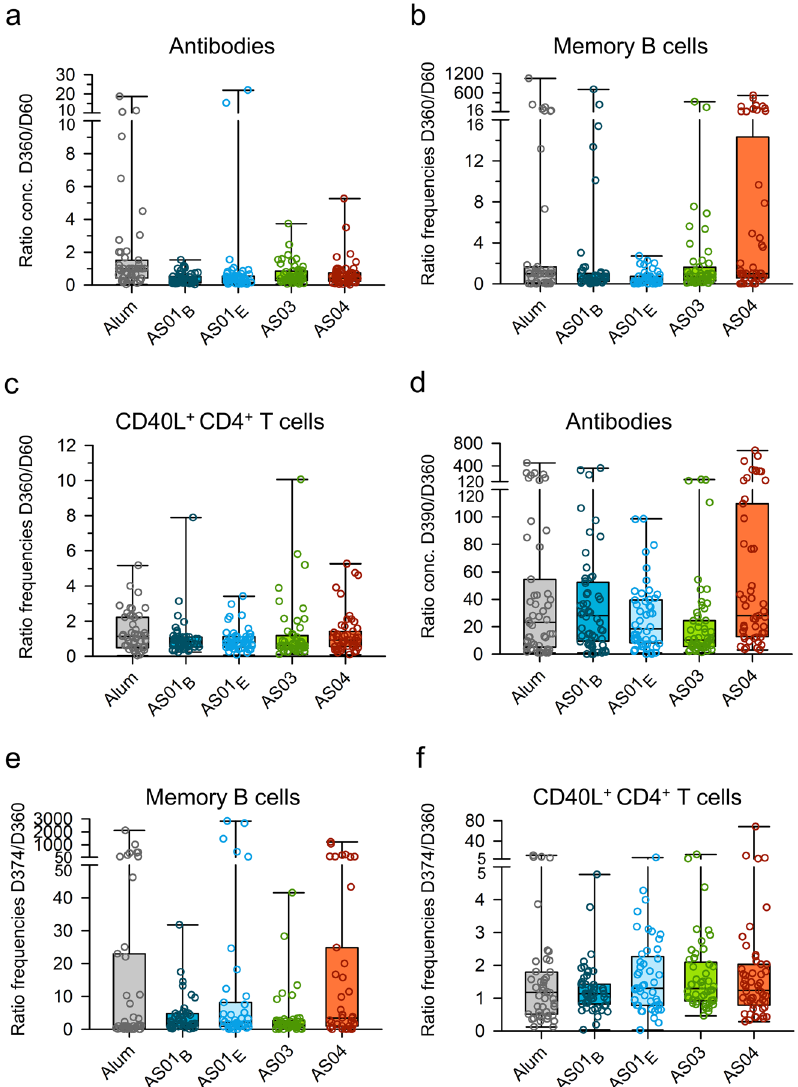
Fig. 2 Persistence and post-antigen recall responses of HBsAg-speci fi c antibodies, memory B cells, and CD4 + T cells in the Booster Cohort. Subjects of the per-protocol Booster Cohort ( N = 265) received two doses of hepatitis B surface antigen (HBsAg) vaccine adjuvanted with AS01 B , AS01 E , AS03, AS04 or Alum at Day (D)0 and D30, and revaccination with non-adjuvanted HBsAg at D360. Ratios of antibody concentrations and B cell or T cell frequencies are presented as D360 over D60 ( a – c ), and as D390 or D374 over D360, i.e., post/pre-antigen recall ( d – f ). Boxplots represent medians, fi rst and third quartiles, minima, and maxima. Each symbol represents an individual for half of the Alum recipients, and in ~20 – 35% of AS recipients. Stronger contrasts between the distributions for Alum and the AS were seen at D390. While for Alum the D360 and D390 distributions were comparable, in the AS groups more recipients displayed increased %FI 1 values at D390 relative to D360 (i.e., curves shifting to the right). This trend appeared most evident in the AS03 group. For example, proportions of subjects with FI 1 ≤ 60% were circa 0.4, 0.5, and 0.7 for AS03, AS01 B , and AS01 E /AS04, respectively, but 1.0 for Alum. These trends were statistically con fi rmed (Kolmogorov-Smirnov test without correction for multiplicity) by signi fi cant intergroup differences, detected only at D390. These differences comprised higher values for AS01 B , AS01 E , AS03, and AS04 than for Alum ( p- values: 0.04, 0.01, 9 × 10 − 5 , and 0.02, respectively), and higher values for AS03 as compared to AS04 ( p -value = 0.04).